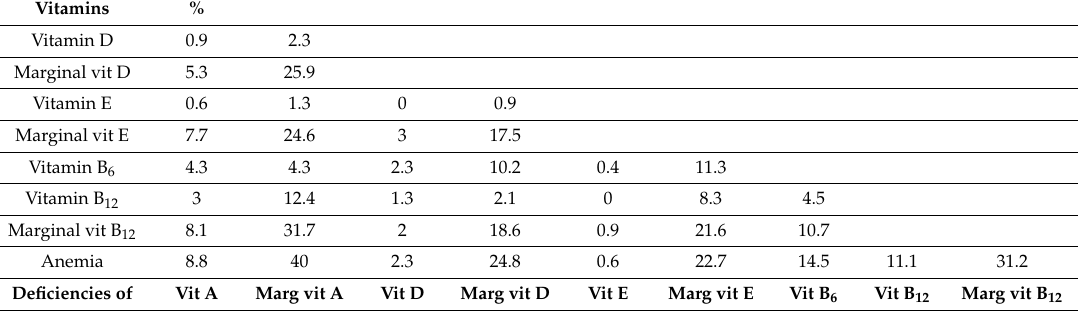
Table 5. Co-existence of multiple vitamin deficiencies and anemia among 467 breastfed infants in Bhaktapur,